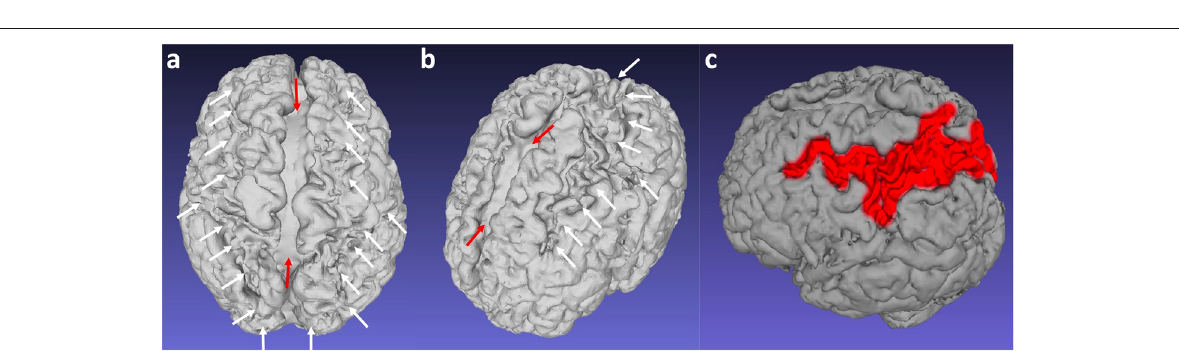
Fig. 13 a – c 3D reconstruction of the cerebral surface after skull stripping and segmentation in a 2-year-old boy who sustained a partial-prolonged hypoxic-ischaemic injury at term gestation. a View of the vertex from above from posterior and ( b ) view of the left hemisphere from above anterior demonstrate continuity of atrophy involving the anterior, parasagittal, peri-Sylvian and posterior inter-arterial watershed zones (white arrows). The inter-hemispheric fissure shows localised bi-convex expansion at the regions worst affected (brackets). c Lateral oblique with the affected posterior inter-vascular watershed region depicted in red — note the continuity with the para-falcine watershed anteriorly and